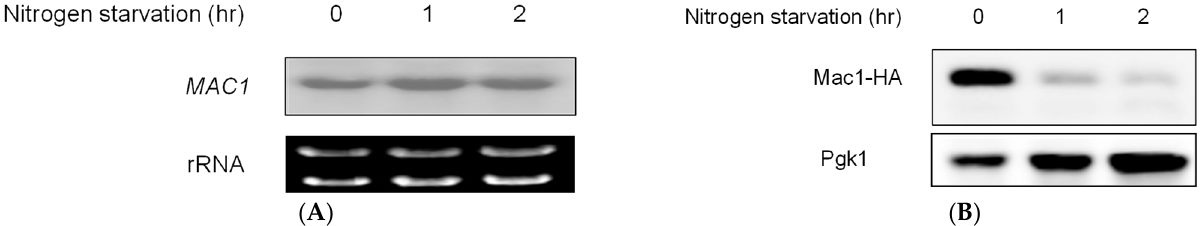
Figure 4. Nitrogen starvation downregulated Mac1 expression at the translational level. ( A ) To identify the reason why the expression of the genes involved in copper uptake was downregulated, northern blotting was performed for MAC1, which is a copper-responsive transcription activator. The cells were starved of nitrogen for the indicated times, and total RNA was extracted. ( B ) To confirm whether nitrogen starvation affects Mac1 expression at the protein level, western blotting was performed. The Mac1-HA strain, which harbors an HA-tagged version of Mac1 in the genome, was cultured and starved of nitrogen for the indicated times, and total proteins were extracted. Pgk1 was used as a loading control.